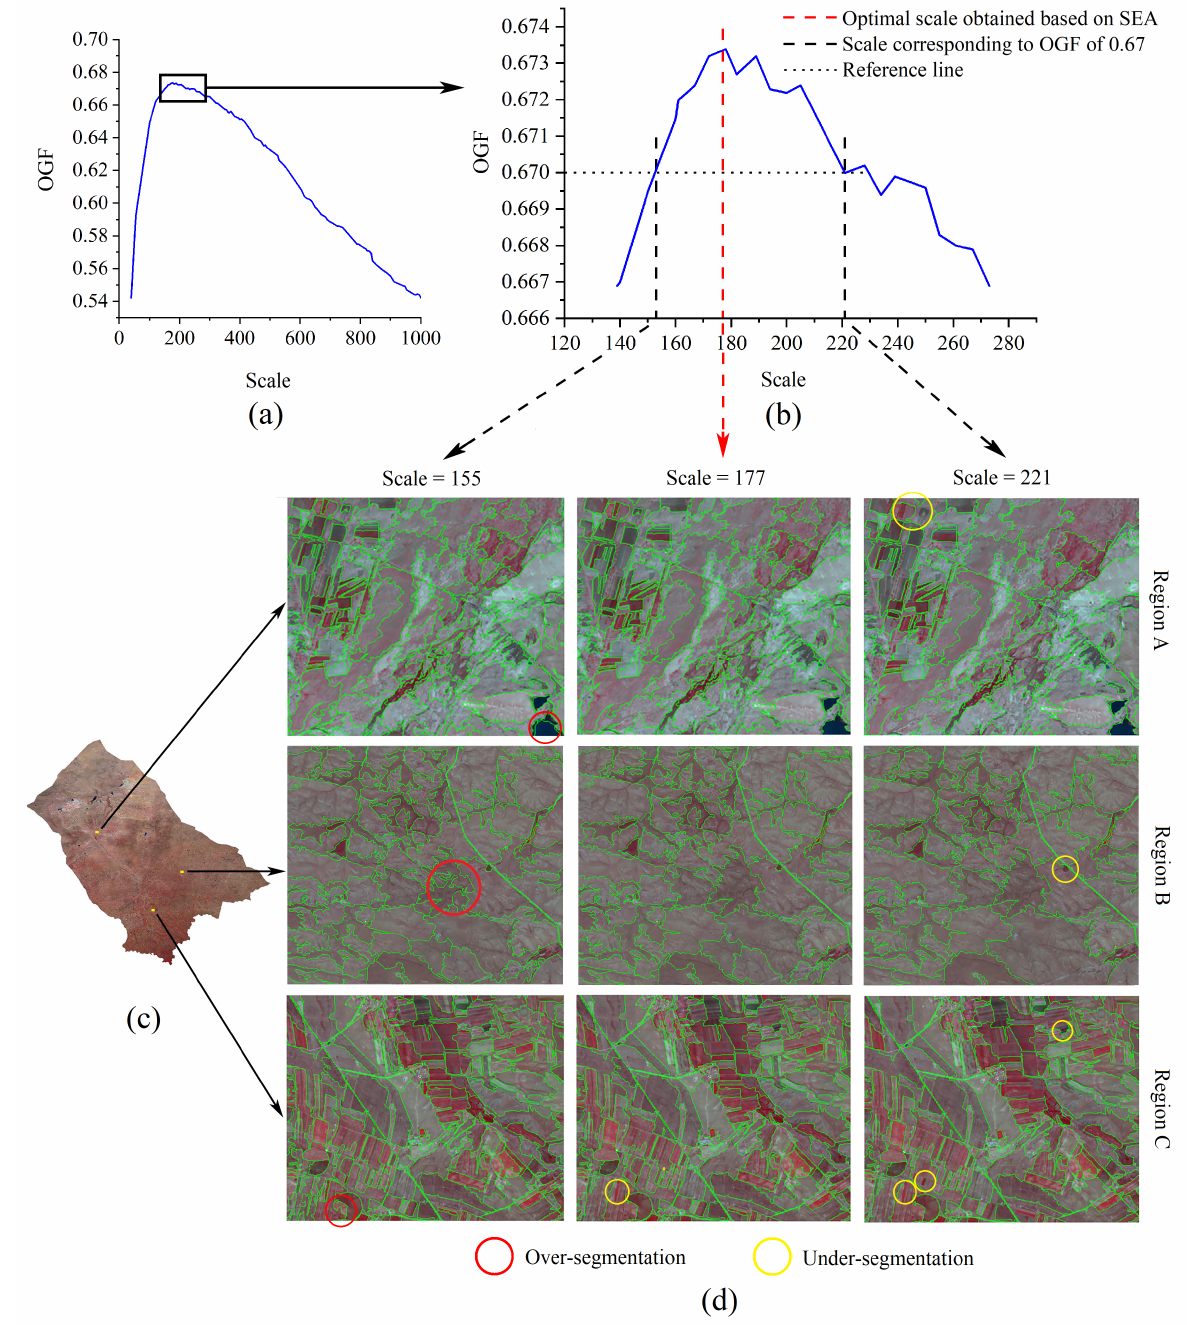
Figure 9. Evaluation of Segmentation Performance. ( a ) OGF curve corresponding to the segmentation scale from 0 to 1000. ( b ) OGF curve corresponding to the segmentation scale from 139 to 272. ( c ) False-color composite Sentinel-2 image of Siziwang on July 3, 2019. ( d ) Segmentation results for the three subregions of Siziwang at scales of 155, 177, and 221,